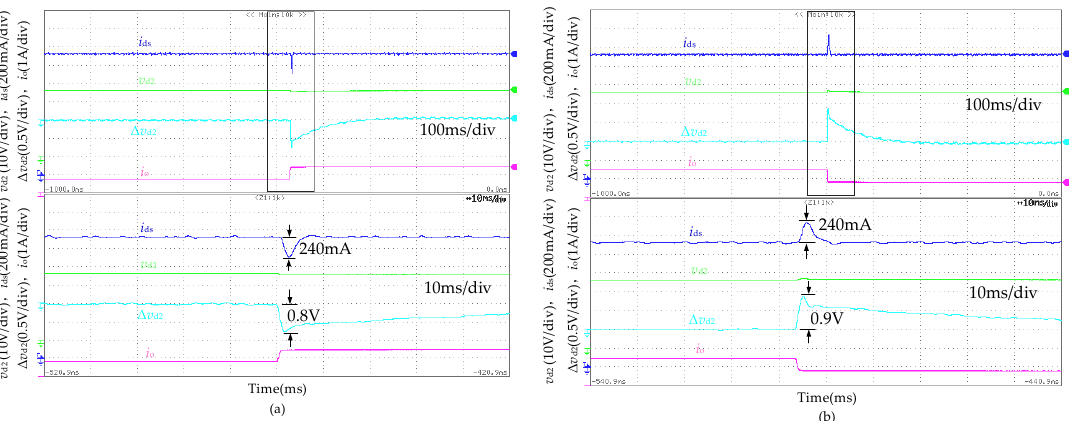
Figure 7. The experiment results of i ds , v d2 , Δ v d2 and i o with the traditional frequency control method and r v = 0.2Ω: ( a ) sudden load increase; ( b ) sudden load decrease.